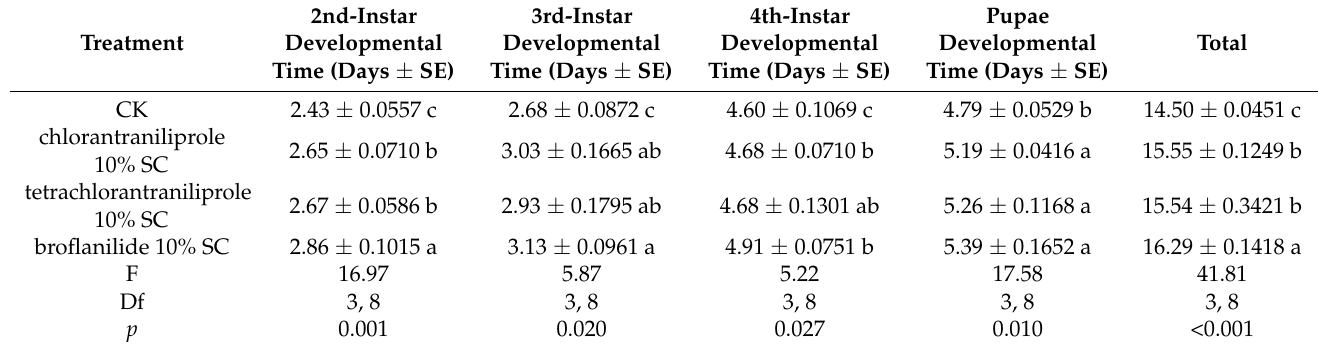
Table 4. The effect of sublethal dose (LR 30 ) of three diamide insecticides on the developmental duration of C. septempunctata .